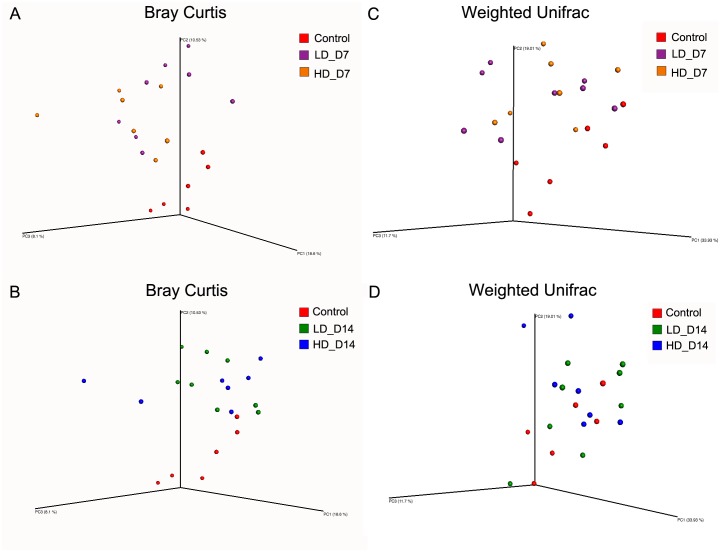
Three-dimensional principal coordinate analysis obtained with Bray Curtis distances (A and B) or weighted UniFrac distance matrix (C and D) of the salmon skin bacterial communities from day 7 infection (A and C) and day 14 infection (B and D).Each dot represents one individual fish. LD_D7: low-dose infected day 7; LD_D14: low-dose infected day 14; HD_D7: high-dose infected day 7; HD_D14: high-dose infected day 14.